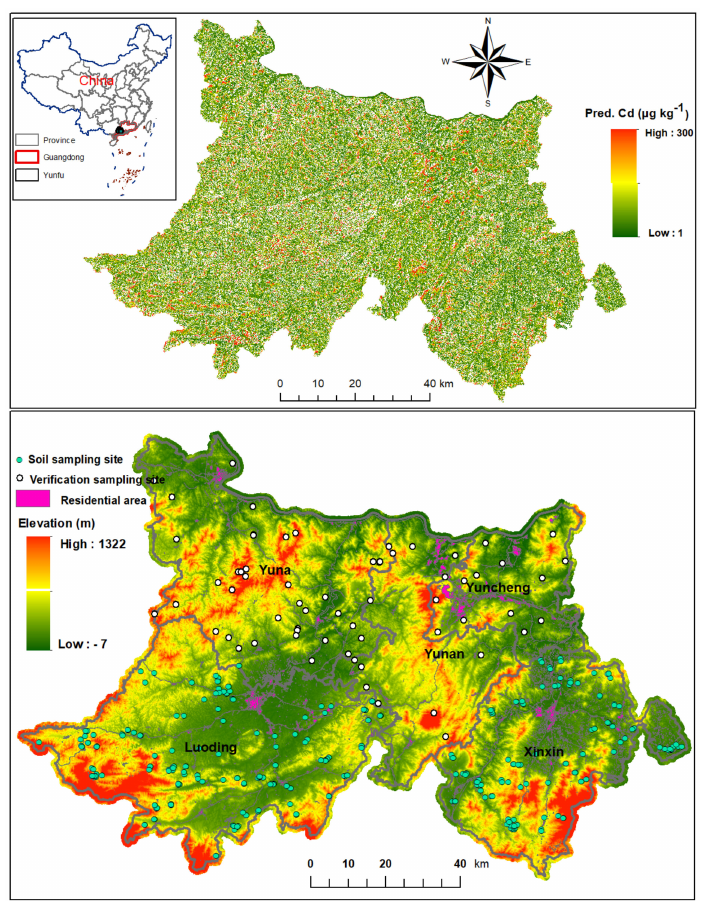
Figure 1. Research site, DEM and soil sampling